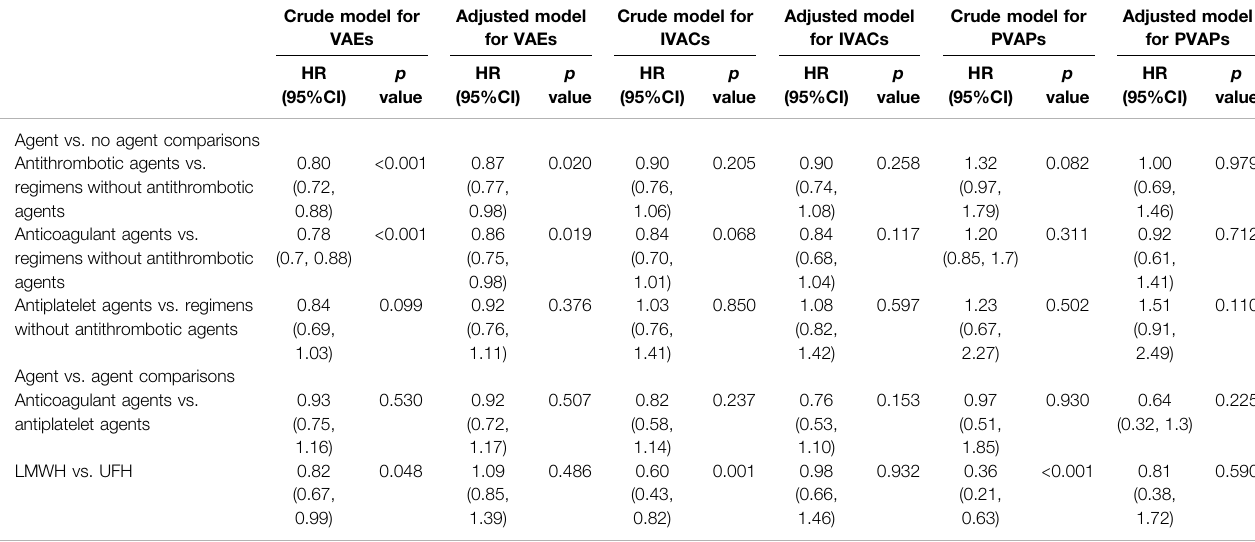
There were differences between regarding hazards for VAEs. Compared to regimens without antithrombosis agent, no found for antithrombotic, anticoagulation, and antiplatelet agent. There were no statistically differences regarding the comparisons of antiplatelet agents vs. regimens without agents, and LMWH vs. UFH ( Table 3 ). TABLE 3 | Association between antithrombotic agents and VAEs. Crude model for